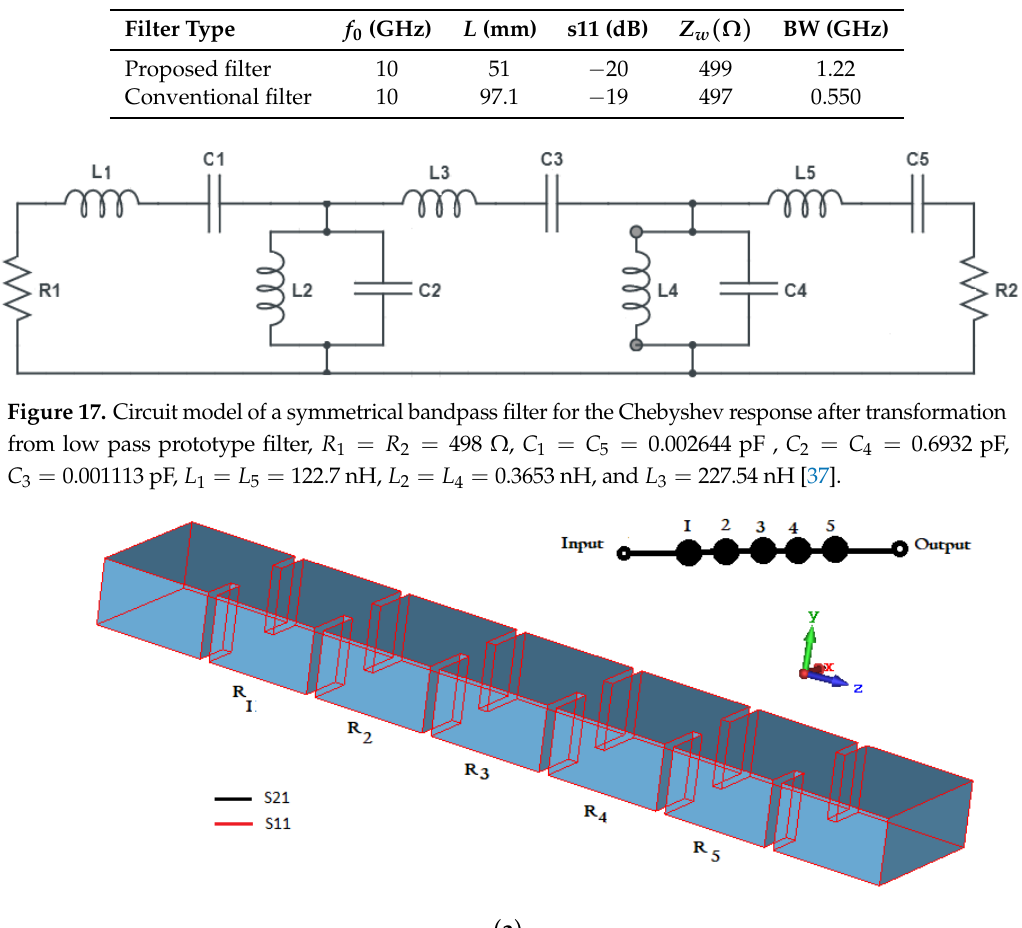
Table 2. Comparison between conventional waveguide bandpass filter and the metamaterial waveguide filter for the X-band at 10 GHz.